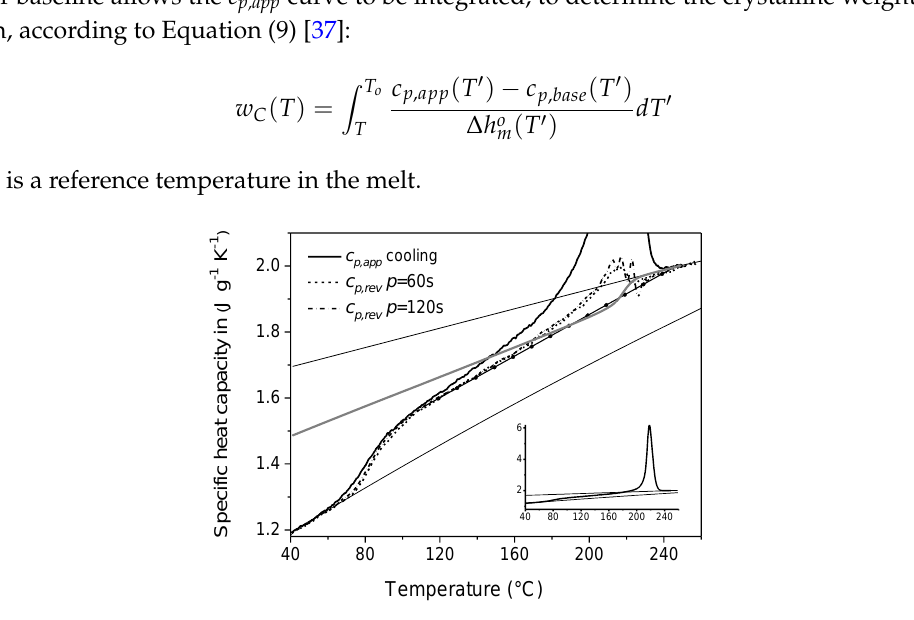
Figure 16. Apparent specific heat capacity ( c p,app ) by standard DSC and reversing specific heat capacity ( c p,rev ) of PET at modulation period of 60 s and 120 s, measured upon cooling from the melt at 2 K min −1 ( A T = 1.0 K). The black solid line with circles is the approximate linear baseline, whereas the solid grey line is the two-phase baseline ( c p,base,2phase ). The black thin solid lines are the solid and liquid specific heat capacities of PET, as taken from [40]. The inset shows the entire c p,app curve. (Reprinted (adapted) with permission from [37]. Copyright (2014) Elsevier).